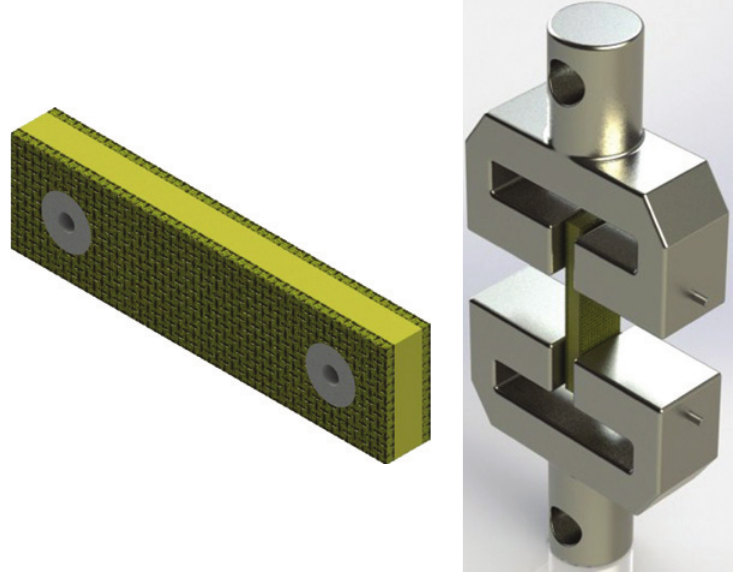
Figure 5 Schematic illustrations of a test sample and tensile test apparatus.